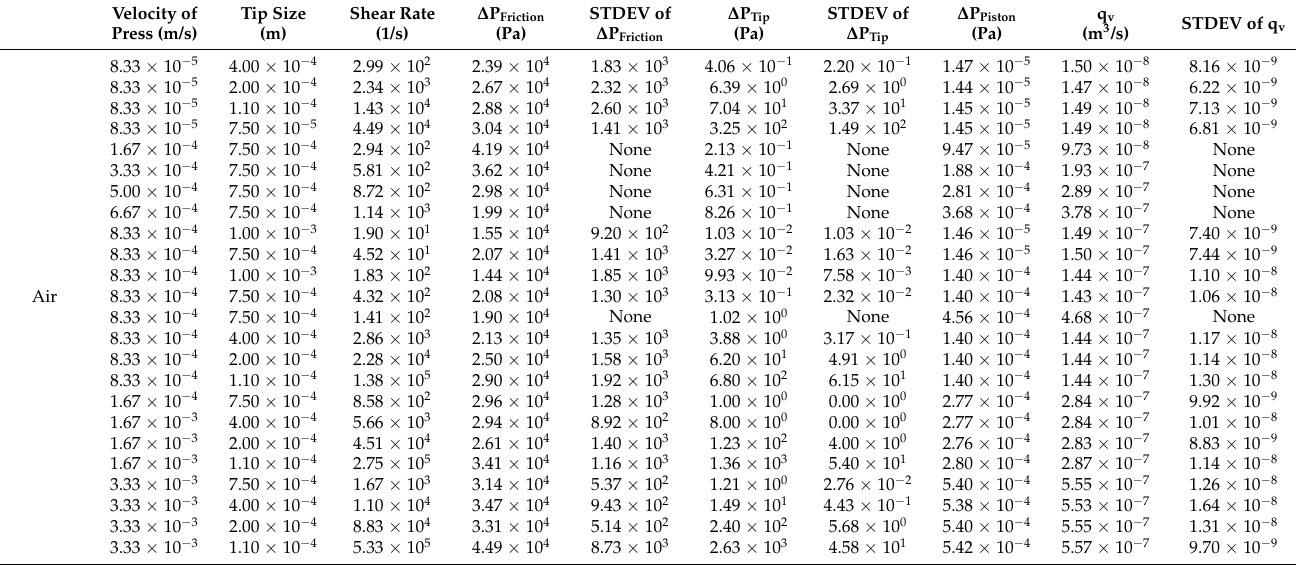
Table 3. Discharge data for air and water volume and pressure intensification experiment results, according to tip size and press-speed (velocity of the press).